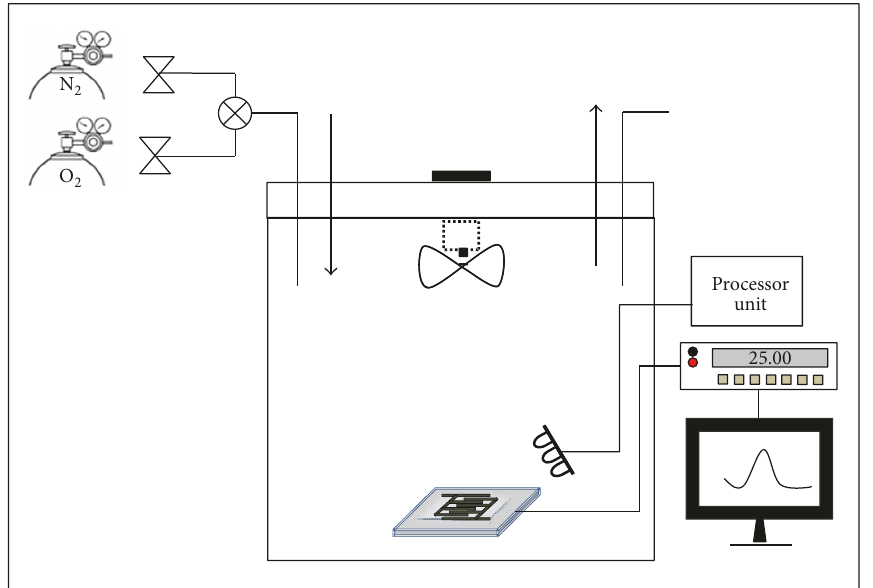
Figure 2: Schematic diagram of the system for gas sensor